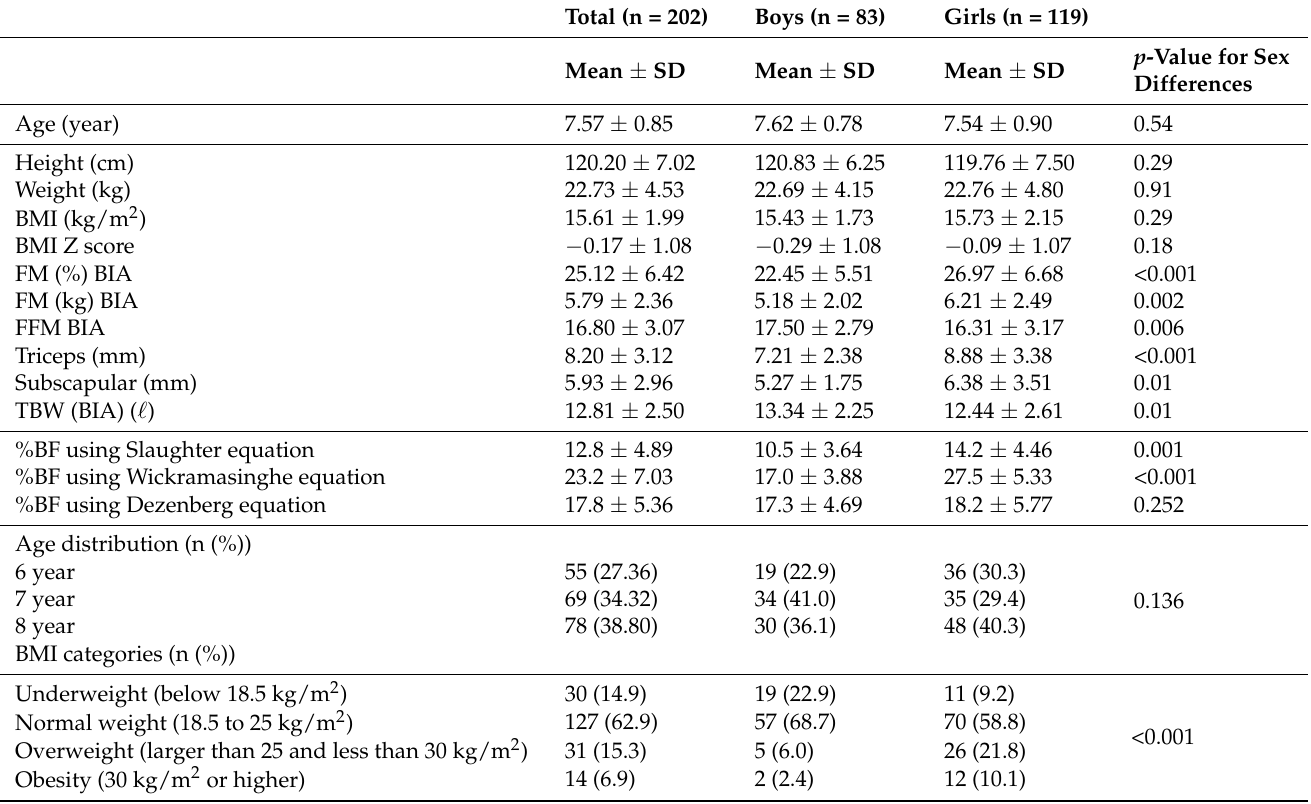
Table 2. Descriptive characteristics of the total group and for boys and girls.